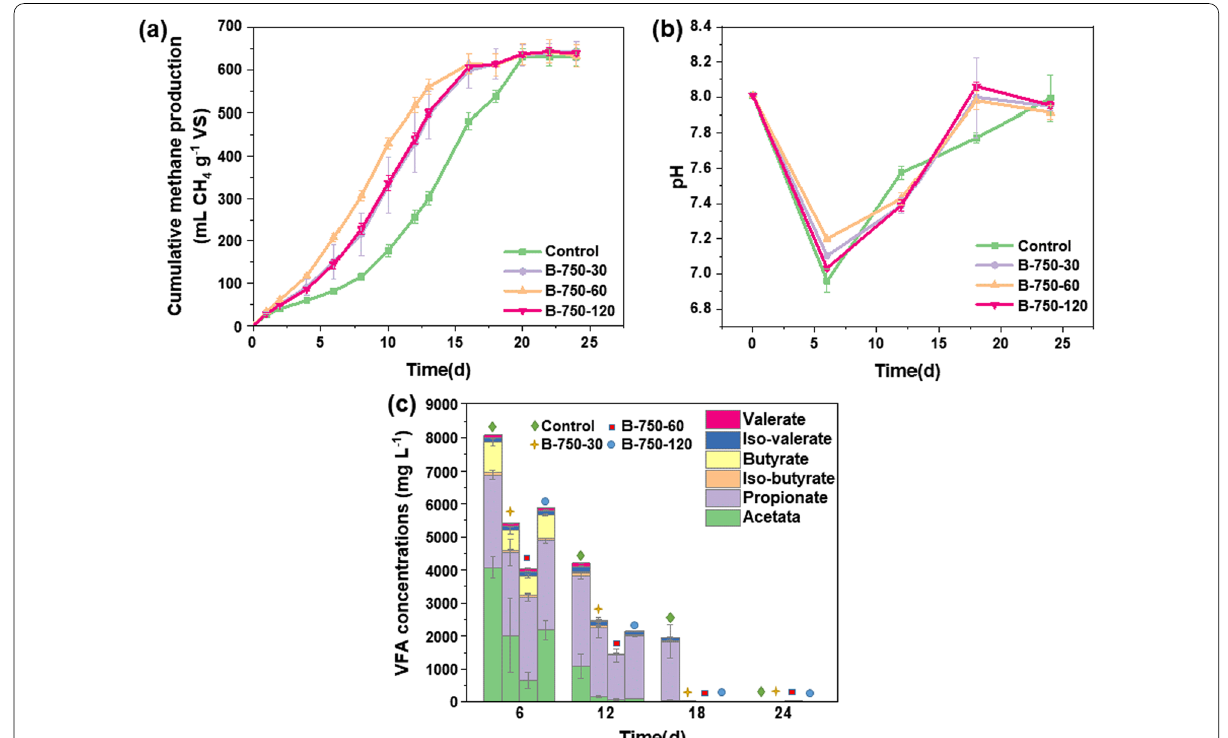
Fig. 1 Effect of biochar prepared under different durations on methane production: a cumulative methane production; b pH variation; c VFAs